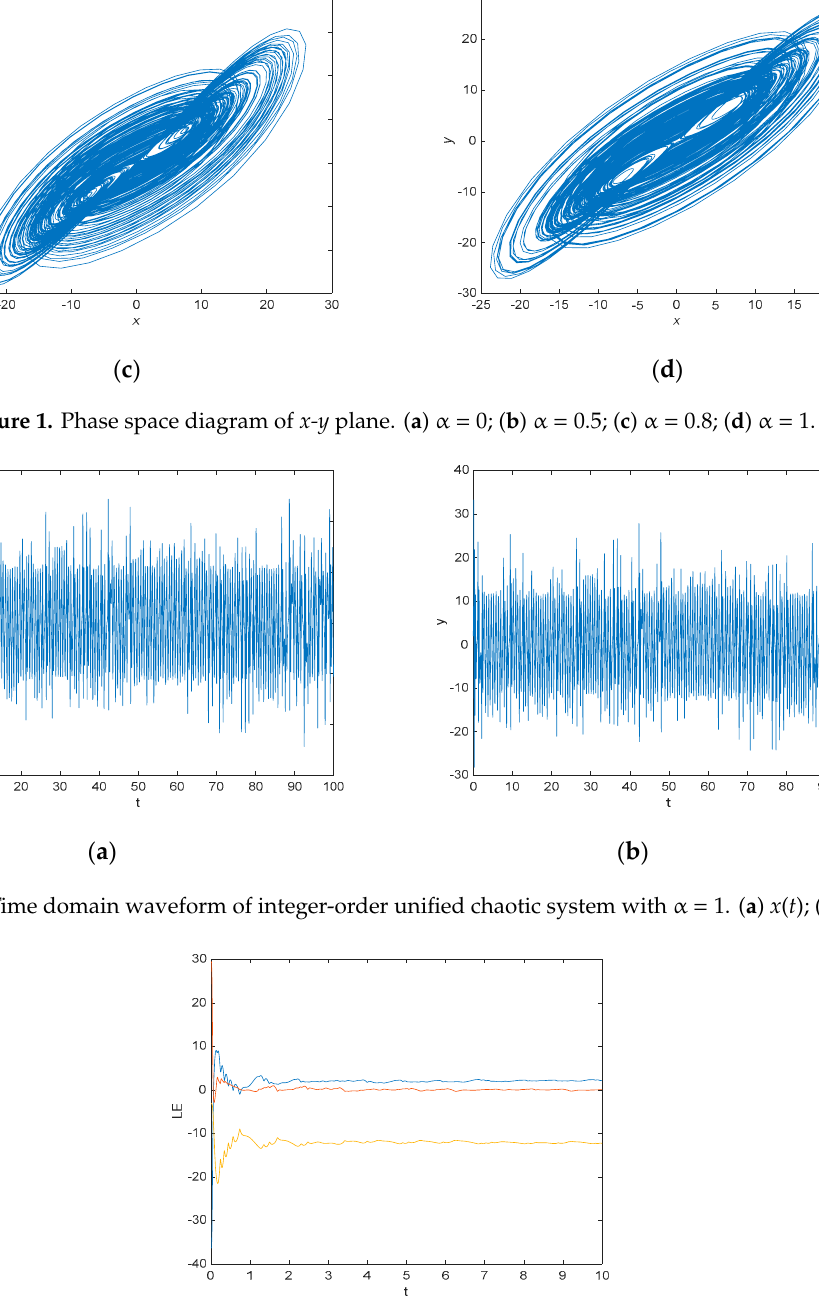
Figure 3. Lyapunov exponent of integral-order unified chaotic system with α ∈ [0.8,1].